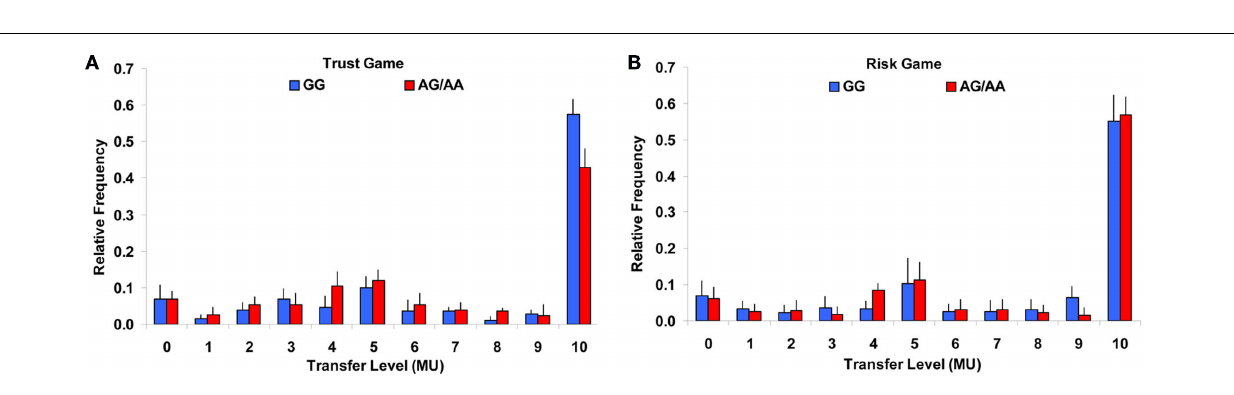
bars) groups level in the trust experiment. (B) Relative frequency of investor’s transfers in GG and AG/AA groups in the risk experiment. MU, monetary